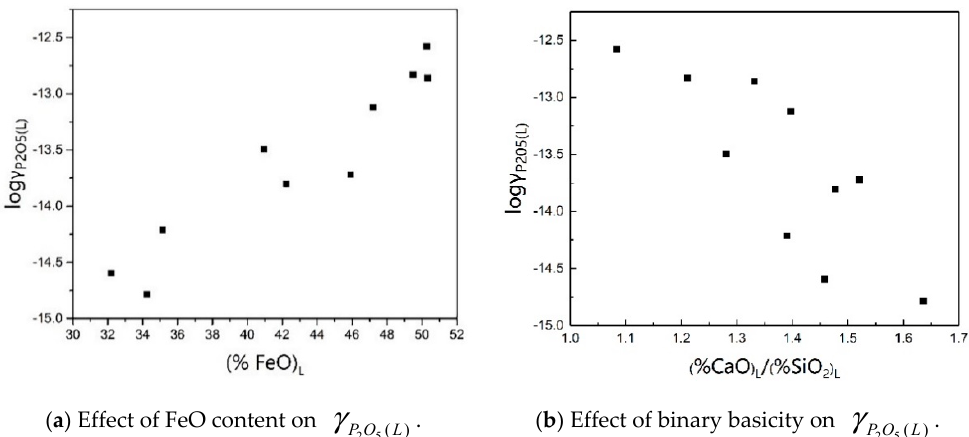
γ . γ 2 5 ( ) P O L . . 2 O 5 ( L ) 2 5 ( ) P O L